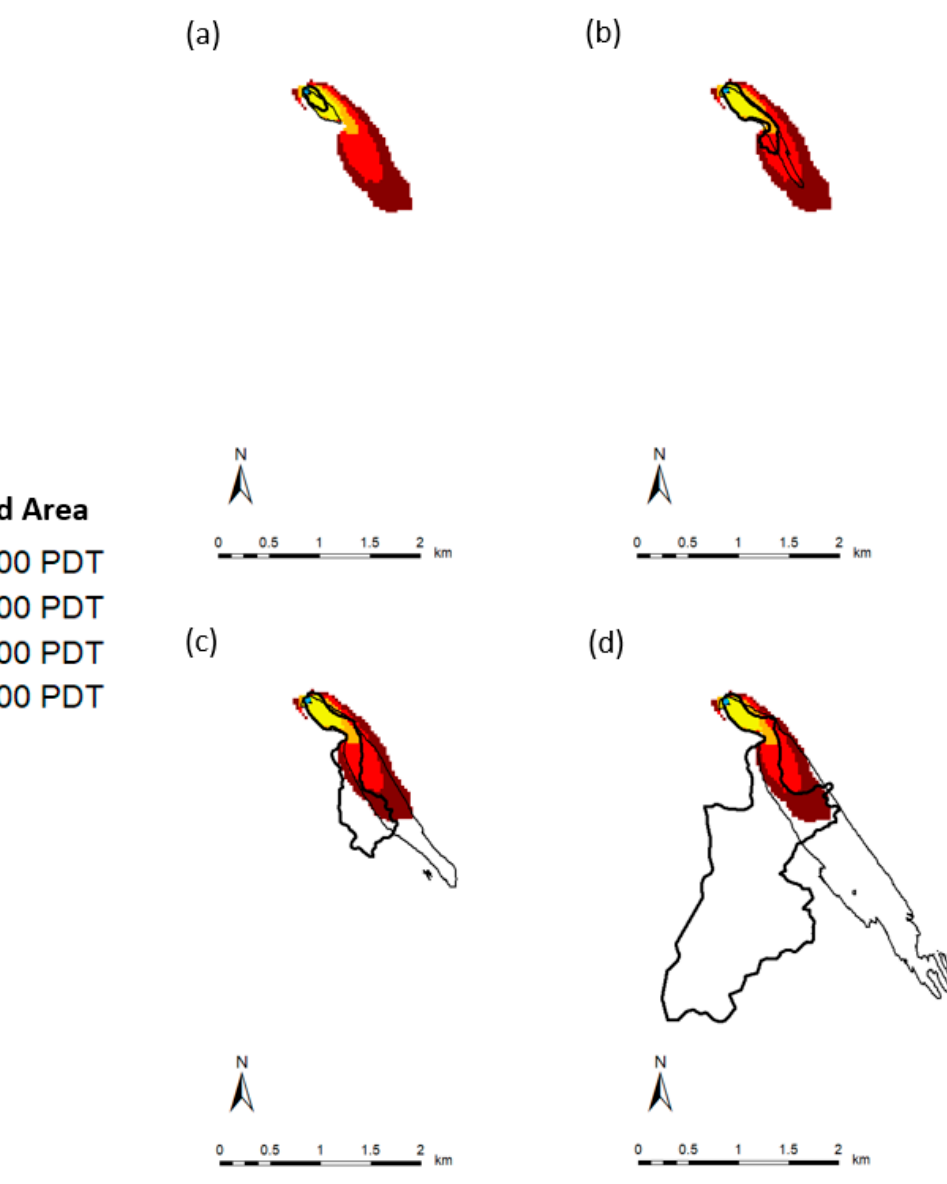
Figure A4. Sherpa fire perimeters with FlamMap local time burnt areas (colored polygons), FARSITE perimeters (thin black polygons), and observed perimeters (thick black polygons) at ( a ) 1600 PDT, ( b ) 1700 PDT, ( c ) 1800 PDT, and ( d ) 1900 PDT.